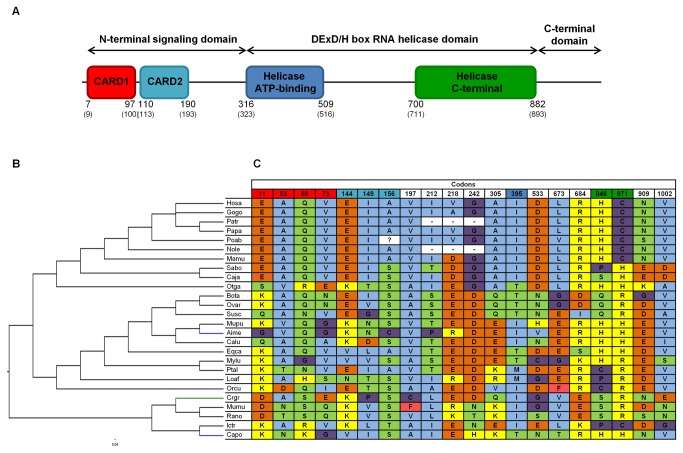
Structural representation and identification of positively-selected branches and codons in mammalian MDA5.(A) Based on the human protein structure, the key domains of MDA5 (http://www.uniprot.org/uniprot/Q9BYX4) and the corresponding boundaries are schematically represented. Also, the human domain boundaries while in the mammalian MDA5 deduced protein sequences alignment (Figure S5) are shown in brackets. (B) Cladogram of 26 mammalian MDA5 genes collected from Ensembl and NCBI databases. Branch-site analyses were performed to identify specific branches episodic under positive selection. Branches with statistically significant likelihood ratio tests (LRTs) when performing PAML branch-site model A (Table 3) are colored in green; branches simultaneously identified by PAML branch-site model A and Hyphy branch-site REL method (Table 5) are colored in blue. (C) Positively-selected codons are exhibited in the table and numbered according to the mammalian MDA5 deduced protein sequences alignment (Figure S5). Symbol “?” represents an undetermined amino acid, while “-” symbolizes a deletion. Colors on the codon numbering row correspond to the MDA5 domain with the same color in the protein structural representation (A). The background colors on the identified sites match different amino acid properties: polar positive (yellow), polar negative (orange), polar neutral (green), non-polar neutral (purple), non-polar aliphatic (blue) and non-polar aromatic (pink). The used abbreviations correspond, by order of appearance, to the following species: Hosa – Human; Gogo – Gorilla; Patr – Chimpanzee; Papa – Bonobo; Poab – Orangutan; Nole – Gibbon; Mamu – Rhesus macaque; Sabo – Black-capped squirrel monkey; Caja – Marmoset; Otga – Bushbaby; Bota – Cow; Ovar – Sheep; Susc – Pig; Mupu – Ferret; Aime – Giant panda; Calu – Dog; Eqca – Horse; Mylu – Little brown myotis; Ptal – Black flying fox; Loaf – Elephant; Orcu – European rabbit; Crgr – Chinese hamster; Mumu – Mouse; Rano – Rat; Ictr – Squirrel; Capo – Guinea pig.